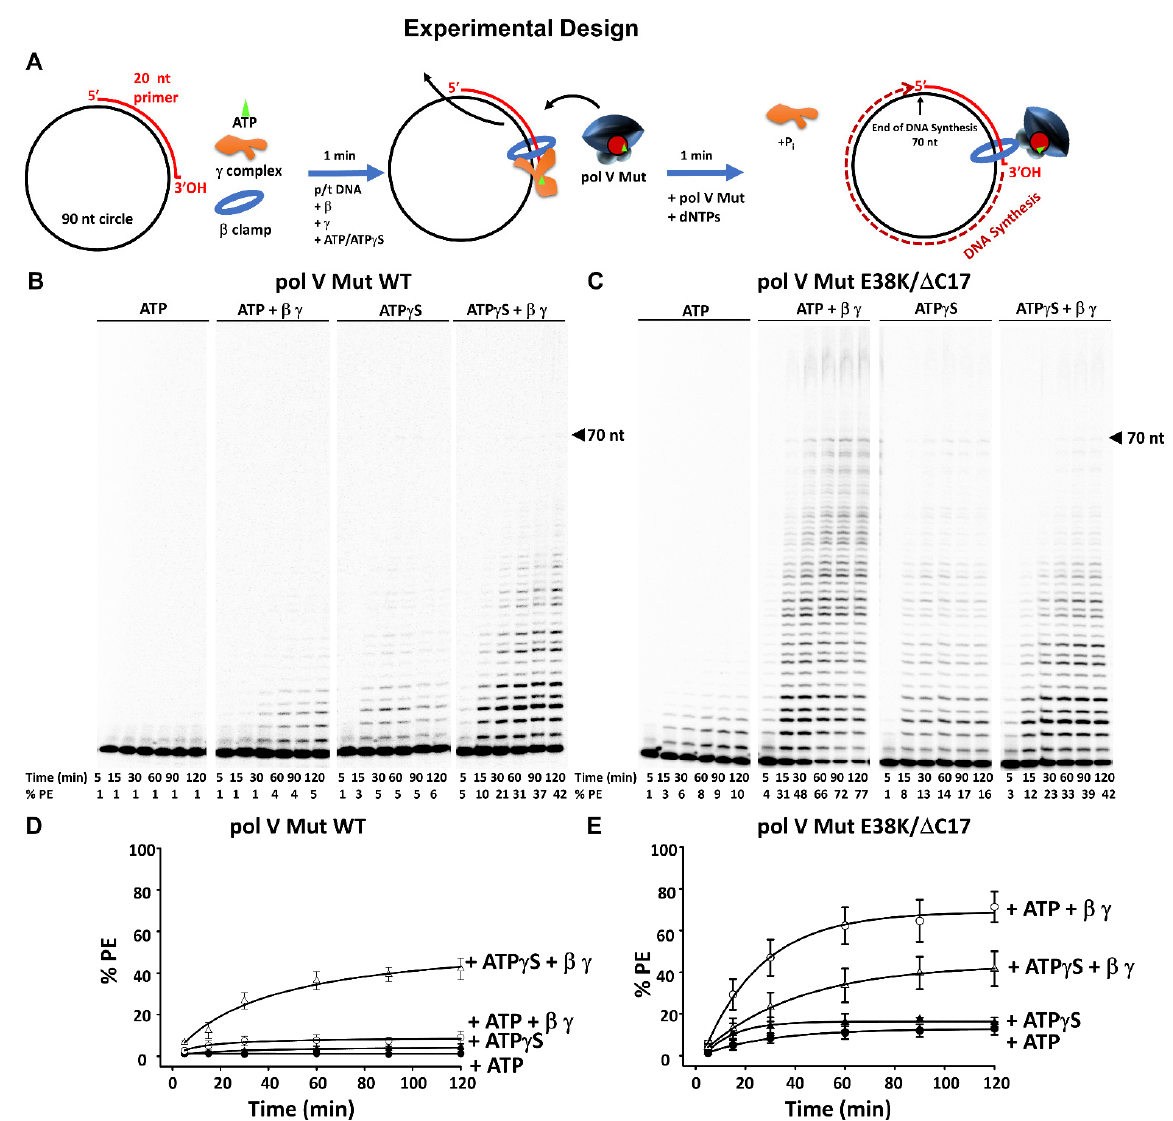
Figure 3. Effect of β -processivity clamp on activity of Pol V Mut. ( A ) Sketch showing experimental set up. Briefly, β -clamp is loaded on circular p/t DNA with γ -complex and ATP/ATP γ S. Activity of pol V Mut WT (400 nM) ( B ), or pol V Mut E38K/ ∆ C17 (400 nM) ( C ), was measured with 20 nt primer/ 90 nt circle (25 nM) in the presence of saturating concentration of ATP or ATP γ S (500 μ M) and dNTP’s (mix of dTTP, dCTP, dGTP 500 μ M each). β -clamp and γ -complex are present in excess of DNA at 200 nM and 150 nM concentration, respectively. The experiments were repeated 3 times and the average % PE (percent p/t DNA extended) with the SD (standard deviation) for each reaction time point is graphed in panel ( D ) for pol V Mut WT and ( E ) for pol V Mut E38K/ ∆ C17.